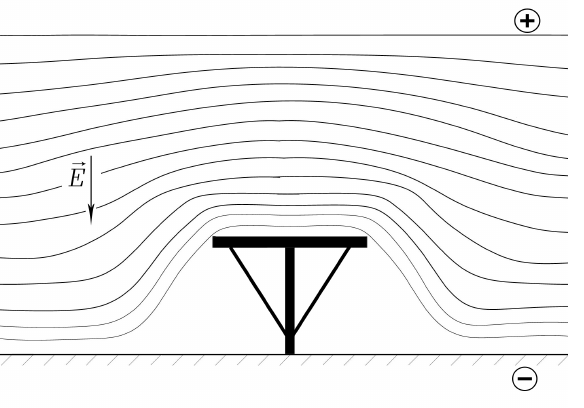
Figure 2. Level surfaces of the electric field strength in the vicinity of the sensor